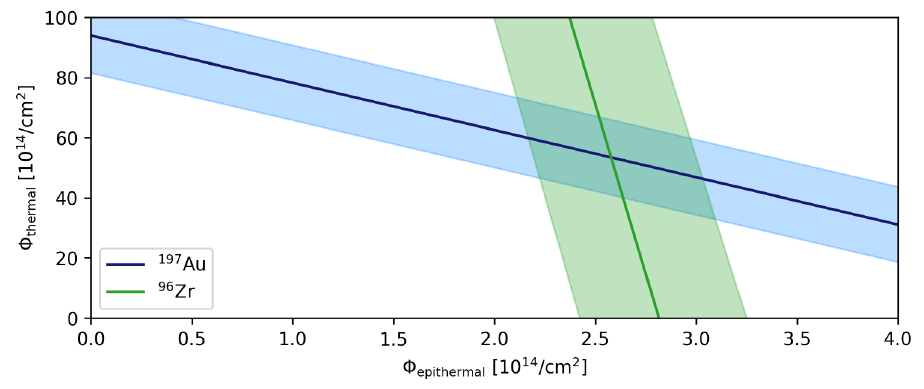
Figure 1. Relation between the thermal neutron flux Φ th and the epithermal component Φ epi determined by a system of linear equations for two